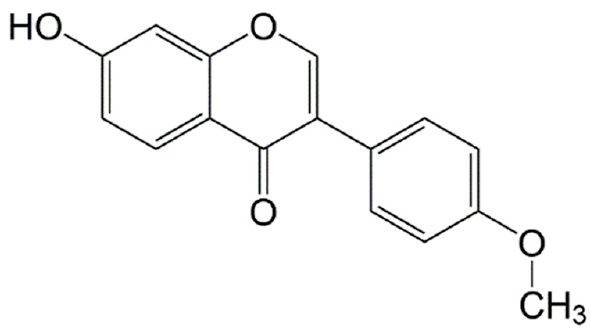
Figure 1. Chemical structure of formononetin (FOR).